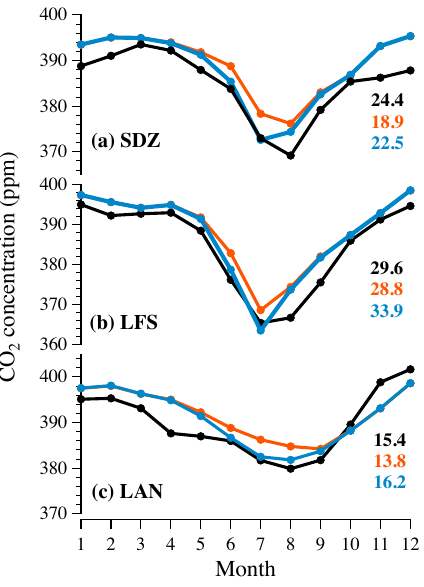
Figure 9. Simulated and observed monthly CO 2 concentrations at three China stations in 2007, the black lines represent the observations, the orange lines represent the simulations from the land fluxes constrained with GV CO 2 only, the blue lines represent the simulations from the land fluxes constrained by additional CONTRAIL CO 2 , and the numbers represent the concentration amplitude between wintertime and summertime